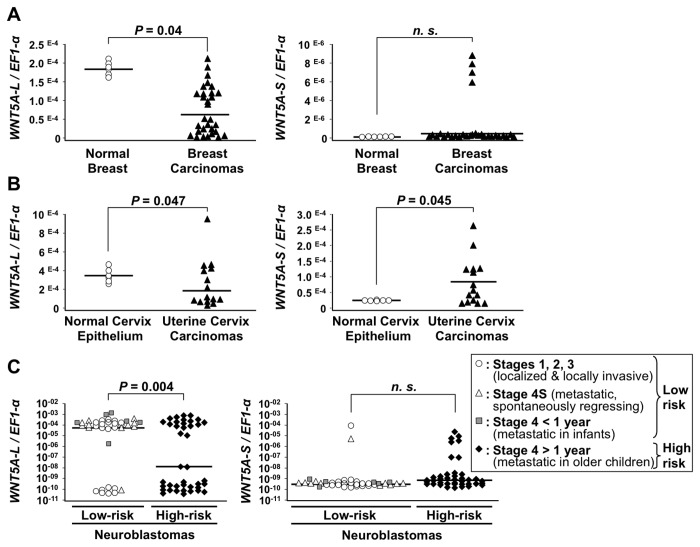
Altered expression of WNT5A isoforms in cancers.Transcript levels of WNT5A-L (left panels) and WNT5A-S (right panels) isoforms were measured in different types of cancers by qRT-PCR and normalized by EF1-α mRNA (normalization by GAPDH mRNA and 18S rRNA produced similar results). Symbols represent mean ratios (WNT5A isoforms/ EF1-α) from at least two independent measurements for each sample. Horizontal bars correspond to the mean expression value of WNT5A isoforms in each subgroup of samples. For breast (A) and uterine cervix (B), expression in carcinomas was compared to that in normal tissues. For neuroblastomas (NB, C), expression was compared between low risk tumors with good prognosis (Stages 1, 2, 3: localized or locally invasive NB; Stage 4S: spontaneously regressing metastatic NB; Stage 4 < 1 year, metastatic NB of infants) and high risk tumors with poor prognosis (Stage 4 > 1 year: metastatic NB of older children). n.s. = not significant.